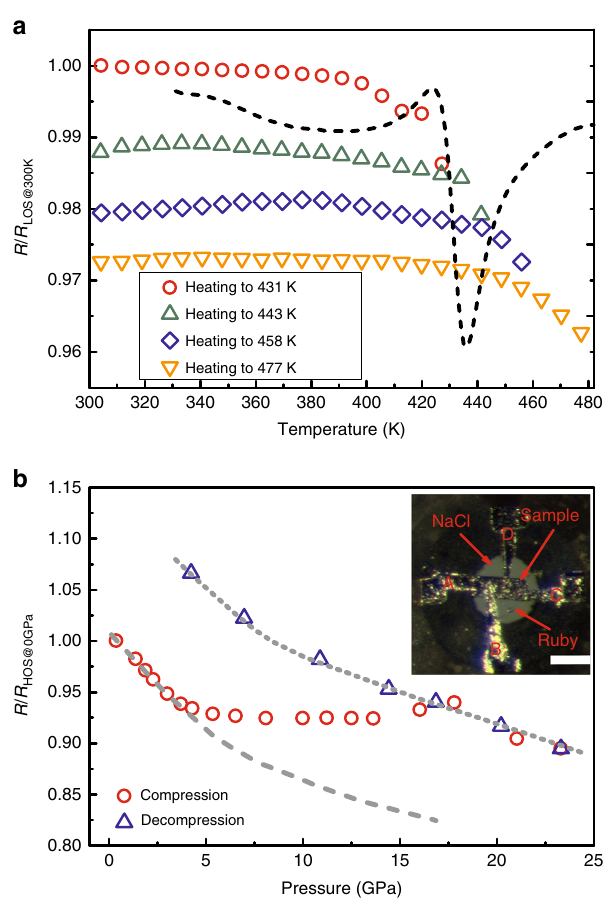
Fig. 4 The resistance measurements of the Ce 65 Al 10 Co 25 MGs during structural ordering and disordering. a The relative resistance changes of the Ce 65 Al 10 Co 25 LOS sample during repeated heating to the different temperatures in the ordering peak of the DSC curve (shown with dash line). It is clear that the resistance decreases obviously once the sample was heated above T 1 , and it is irreversible and quenchable to room temperature. b The relative resistance change of the Ce 65 Al 10 Co 25 HOS sample under compression and decompression. Two different states, HOS and LOS/HP- LOS, are indicated by dashed and dotted lines. The resistance of the sample fi rstly changes along the dashed line during compression, above ~ 5 GPa it deviates from the initial trend and eventually follows the new trend of the dotted line with a transition zone from ~ 5 GPa to ~18 GPa. The inset displays the image of the HOS sample in the DAC for resistance measurement together with four Pt foil electrodes and a ruby ball for pressure calibration. The scale bar represents 100 μ m. The error bars for the resistance and pressure measurements are both smaller than the symbol